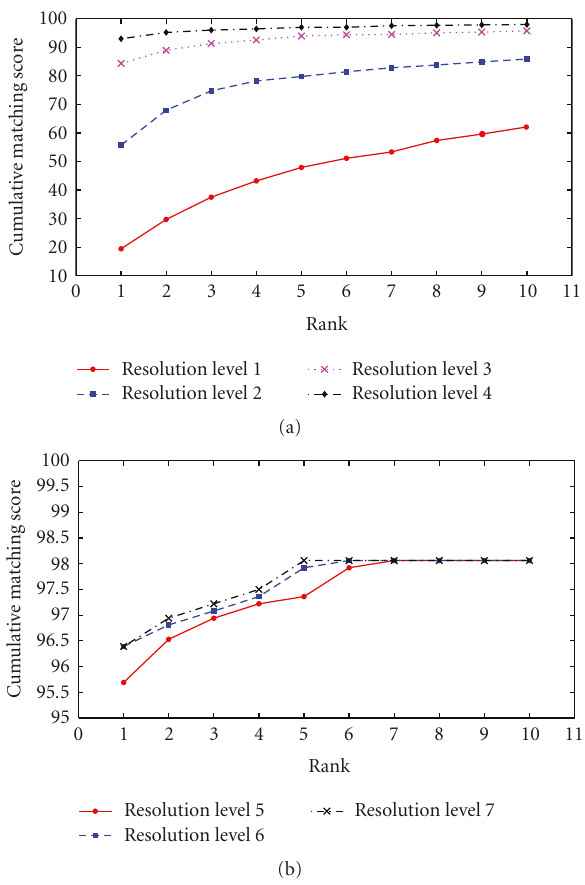
Figure 14: The CMS at di ff erent resolution